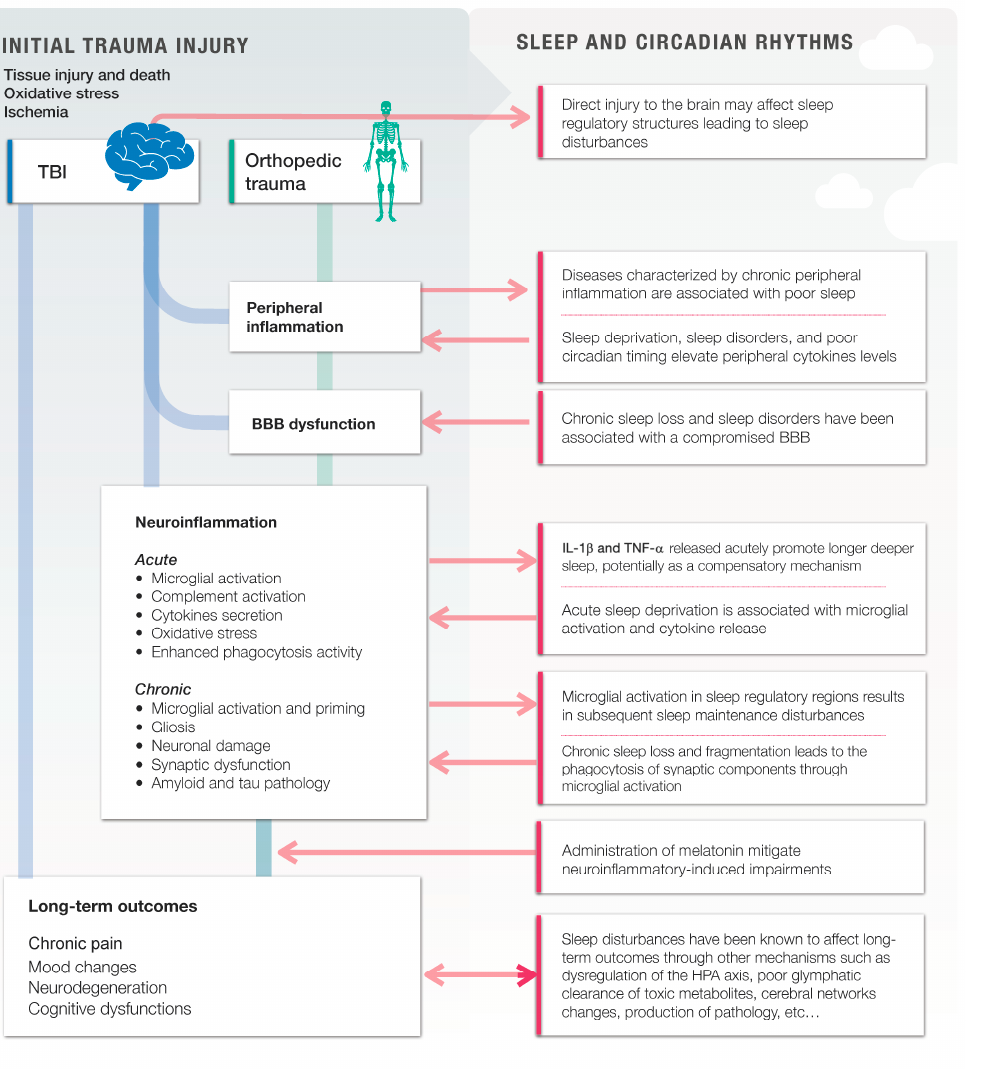
Figure 1. The putative role of neuroinflammation in the acquired traumatic injuries and related sleep disturbances. Traumatic brain injuries (TBI) and orthopedic traumas (OT) both lead to a down- stream pathophysiological cascade that includes peripheral inflammation, blood–brain barrier (BBB) dysfunction, and neuroinflammation. In turn, chronic neuroinflammation plays a role into the development of poor long-term outcomes. At each step of the way, sleep and sleep disturbances interact bidirectionally with traumatic pathological mechanisms and neuroinflammation. Poorer sleep exacerbates peripheral inflammation, BBB dysfunction, neuroinflammation, and worsen long- term outcomes. On the other hand, the trauma itself, its comorbidities, or neuroinflammation affect sleep regulation, which leads to a positive feedback loop, where neuroinflammation and sleep in- teract together to affect long-term outcomes following an injury. 4. Future Directions for Clinical Practice: Targeting Neuroinflammation